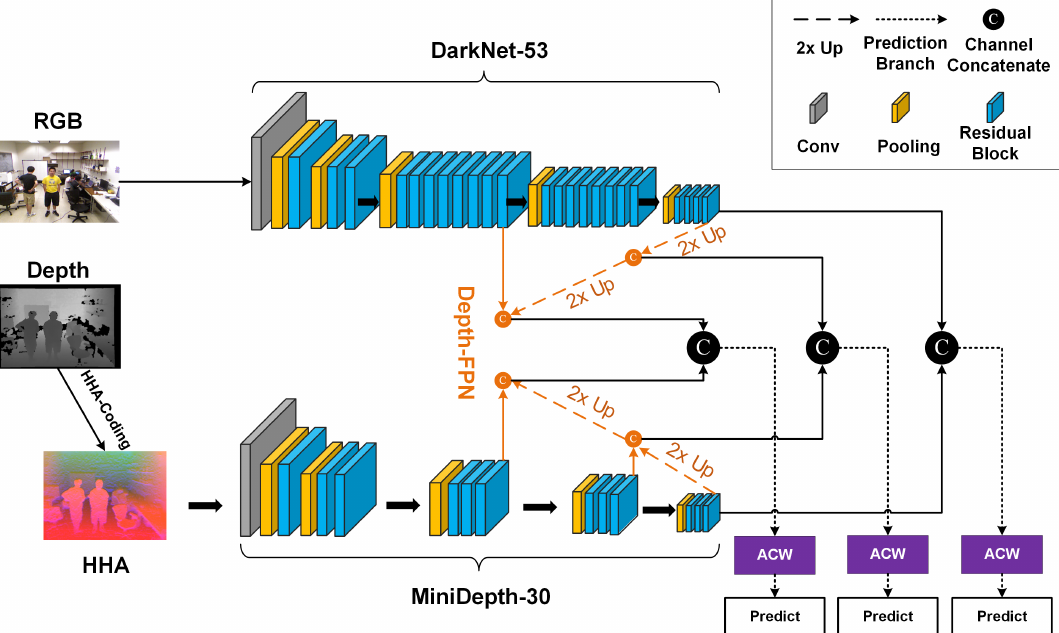
Figure 1. Overview the structure of the proposed asymmetric adaptive fusion two-stream network (AAFTS-net) for RGB-D human